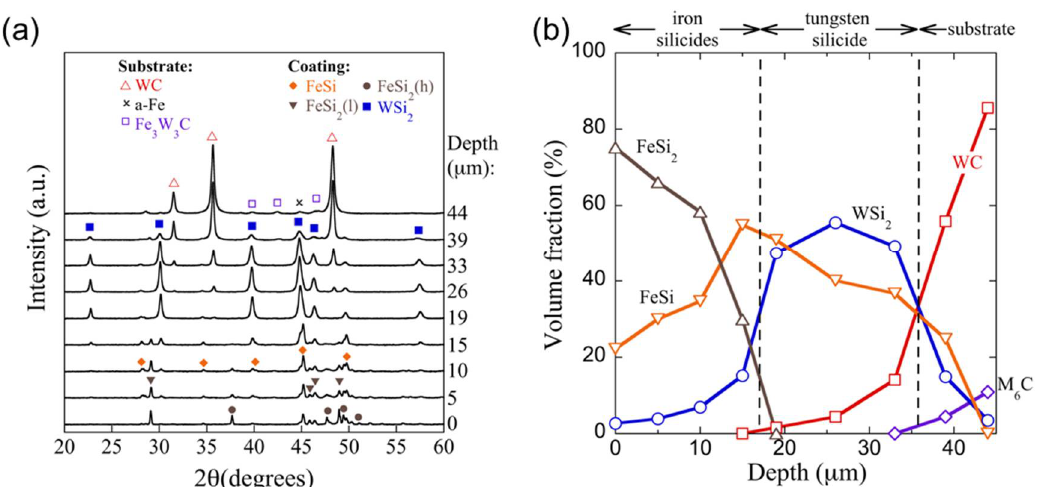
Figure 6. ( a ) XRD patterns through the thickness of the coating after 1 h silicon deposition. The surface (0 µ m) is predominantly FeSi 2 + FeSi. No obvious carbon-containing reaction product between WC and Si is visible. ( b ) Rietveld-determined volume fraction of phases plotted as a function of depth.